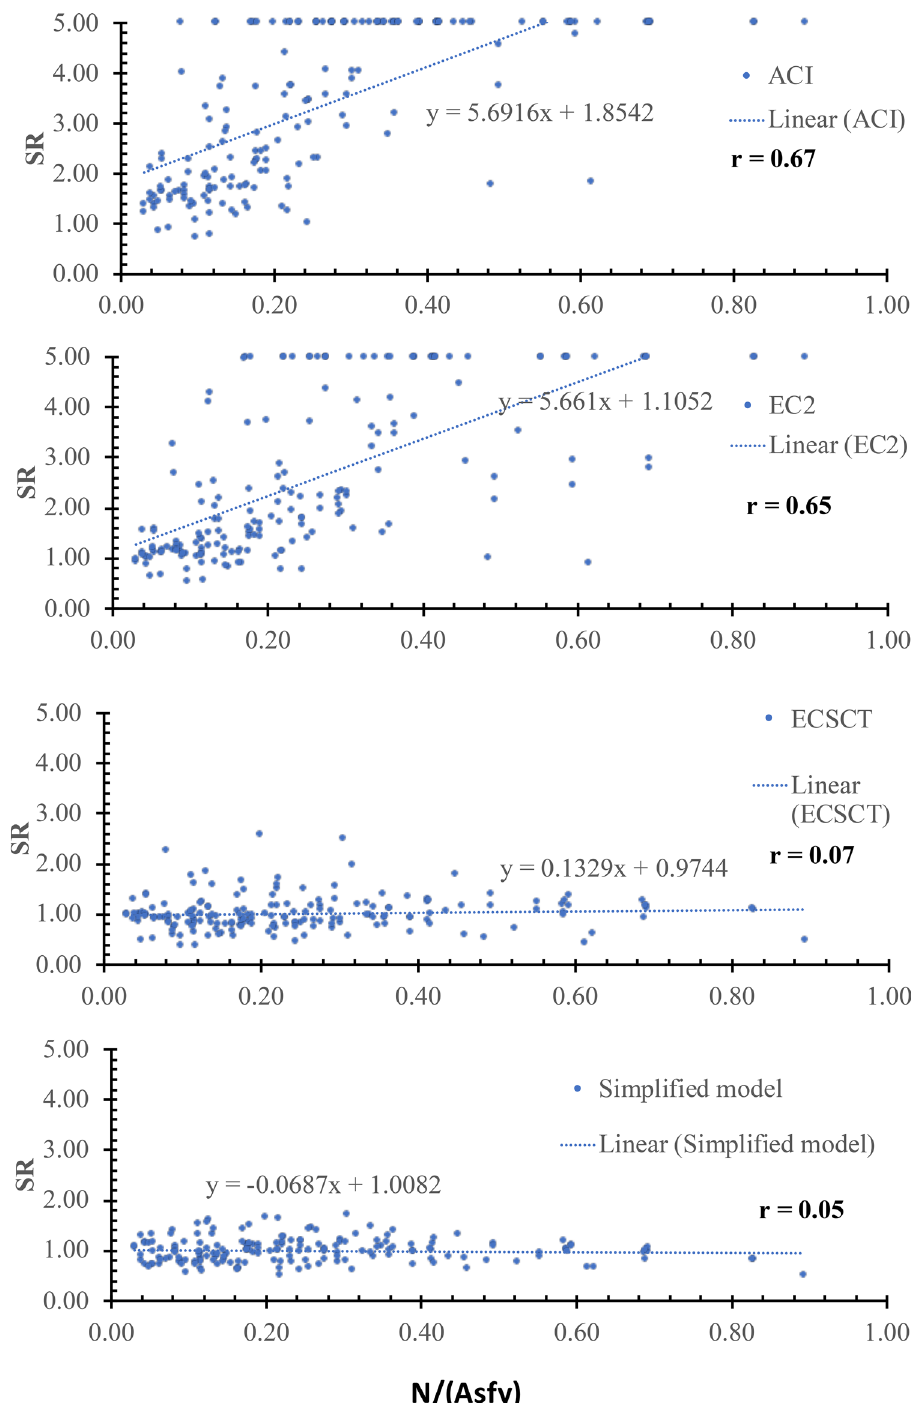
Figure 8. SR using various methods versus the N /( ρbdf y